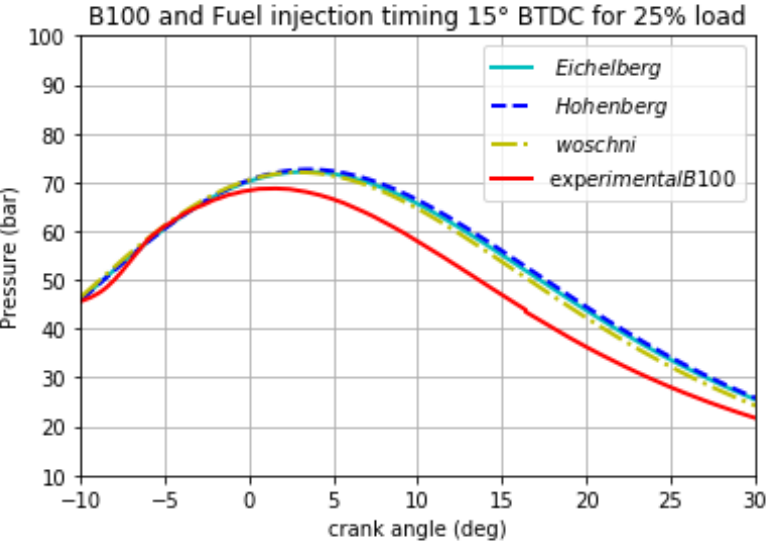
Figure 8. Cylinder pressure of B100 at 25% load.